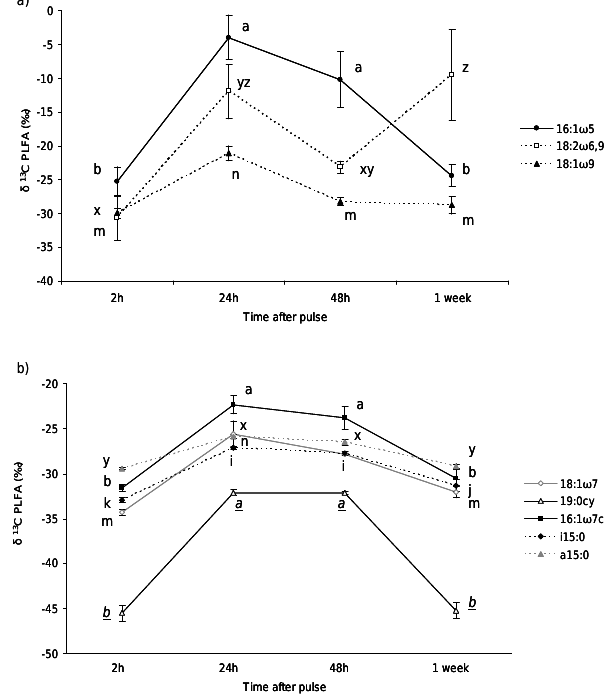
Fig. 4. 13 C enrichment over a 1-week 13 CO 2 pulse-chase period in (a) fungal PLFAs and b) bacterial PLFAs. Values are means ± 1SE and means of the same PLFA not sharing the same letter are signif- icantly different between the respective times ( P < 0.05; N = 12). Solid line indicates AMF (a) or gram negative bacteria (b) , dotted line indicate saprophytic fungi (a) or gram positive bacteria (b)